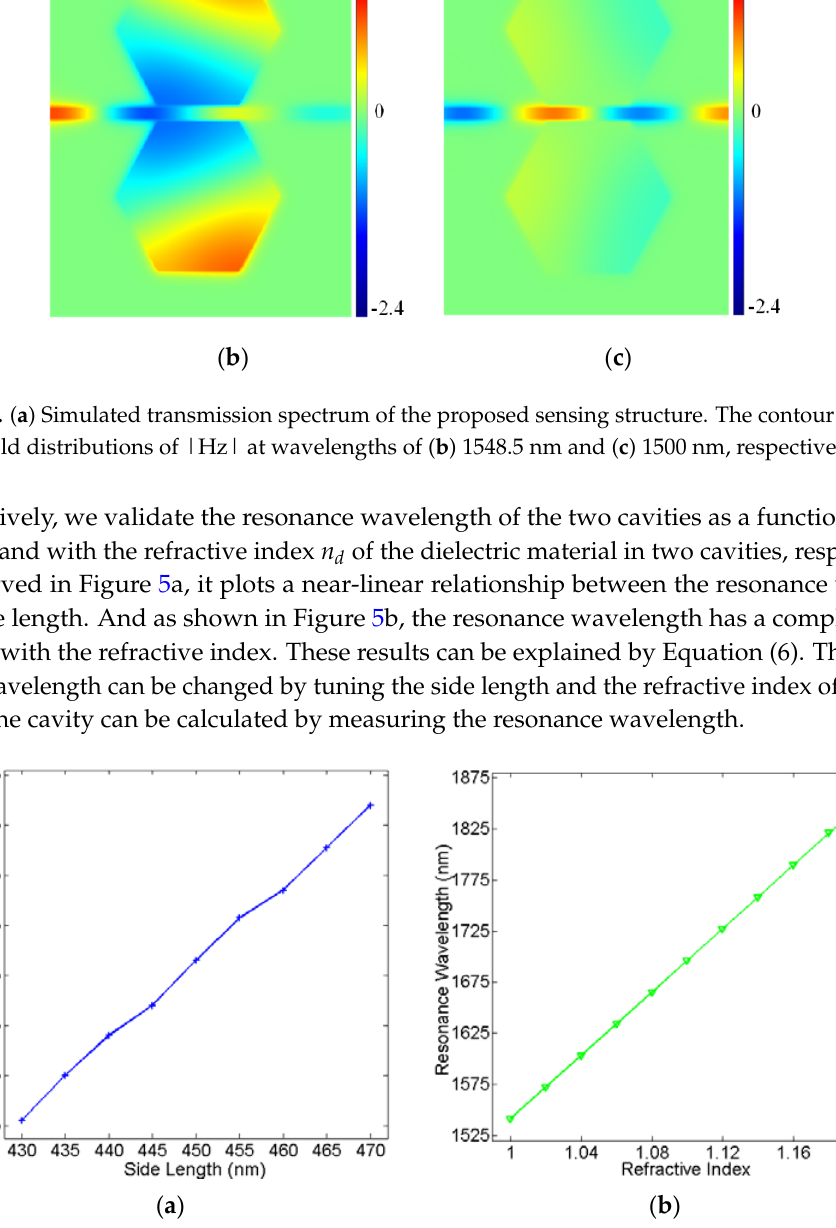
Figure 5. Resonance wavelength of the plasmonic sensor versus ( a ) side length L and ( b ) the refractive index n d of the dielectric material in the cavities.